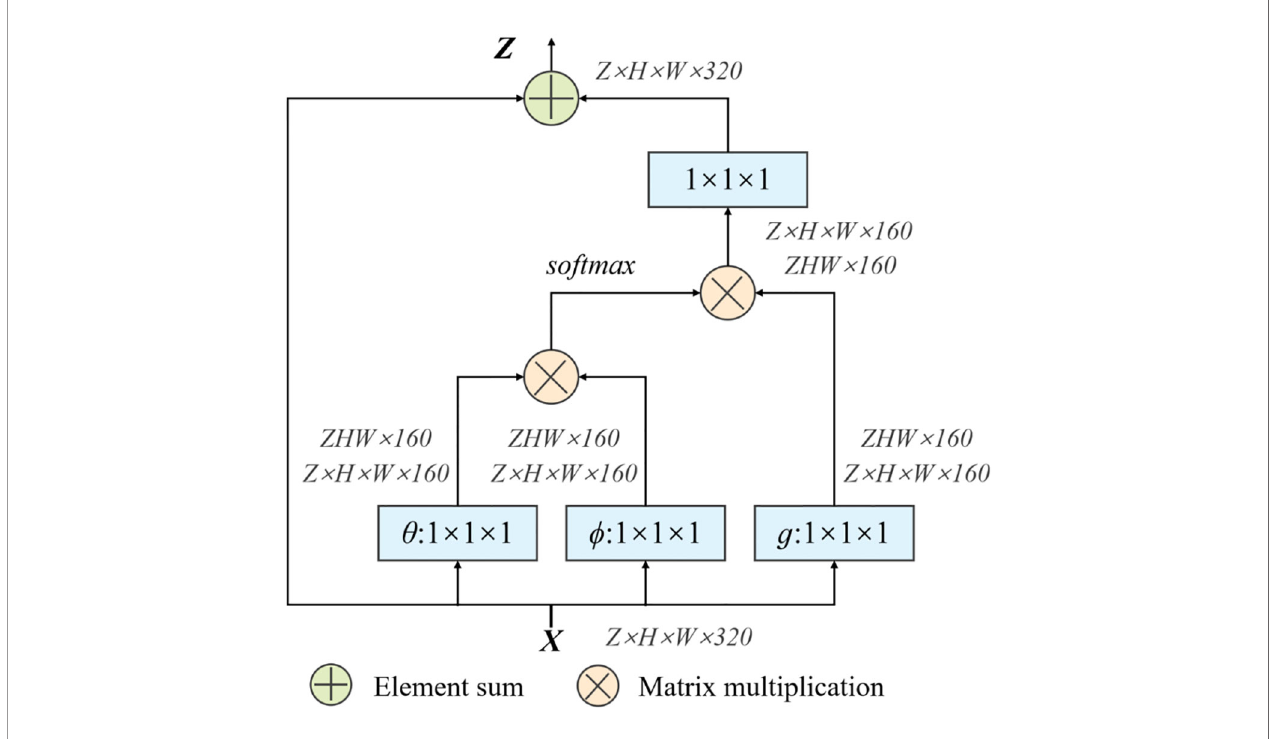
FIGURE 5 | Structure of Non-Local module